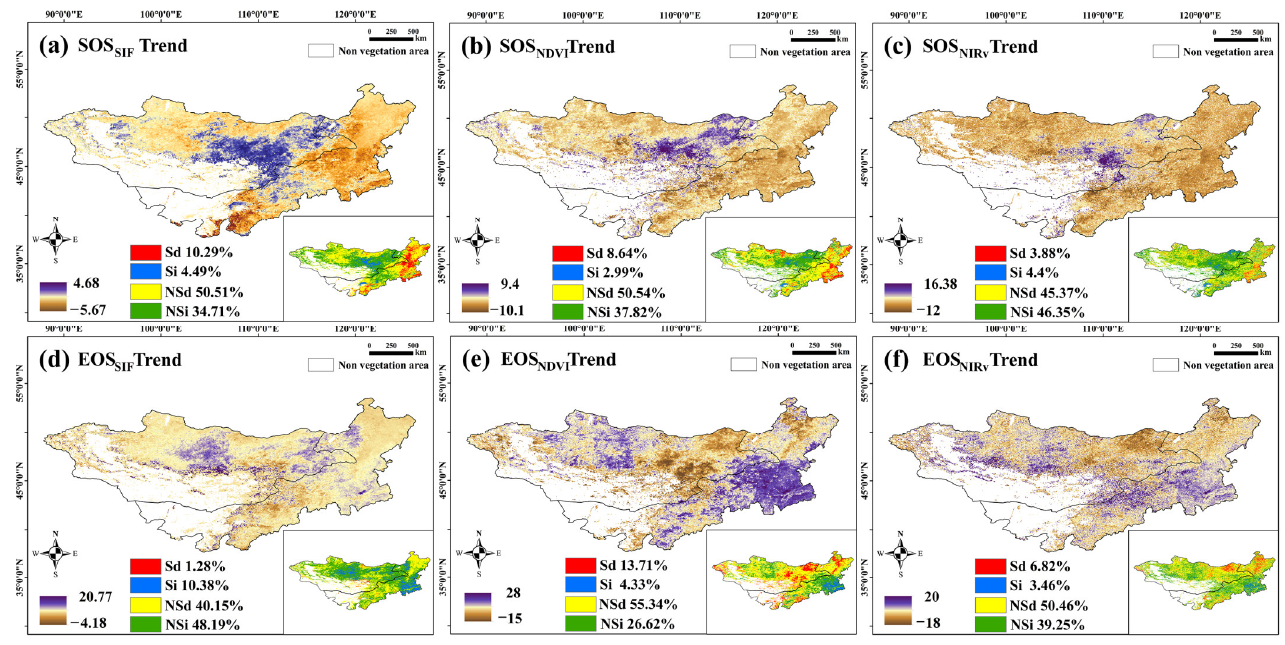
Figure 4. Comparison of the spatial-distribution trends of the phenological parameters extracted based on SIF, NDVI and NIRv. Sd: significant decrease; Si: significant increase; NSd: nonsignificant decrease; NSi: nonsignificant increase.